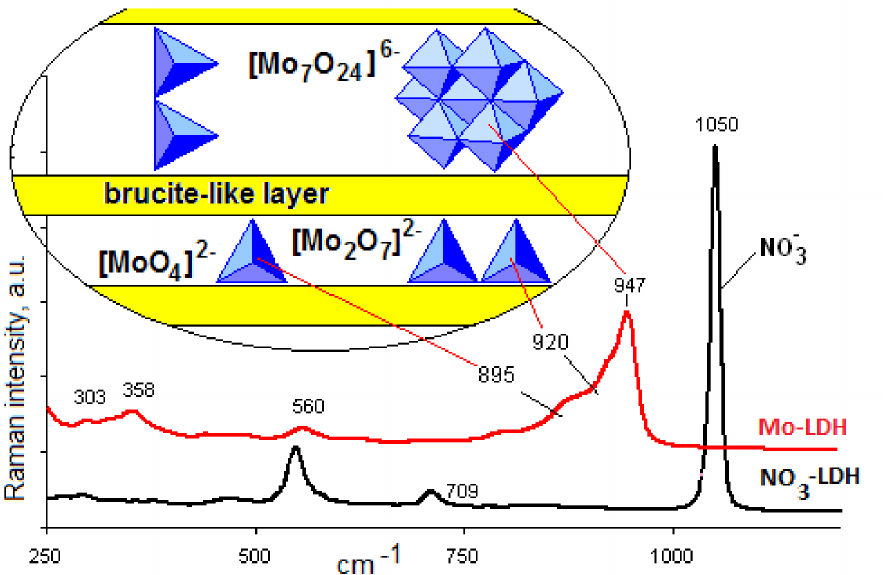
Figure 8. Raman spectra of NO 3 -LDH and Mo-LDH. Reprinted with permission from ref. [113]. Copyright 2012